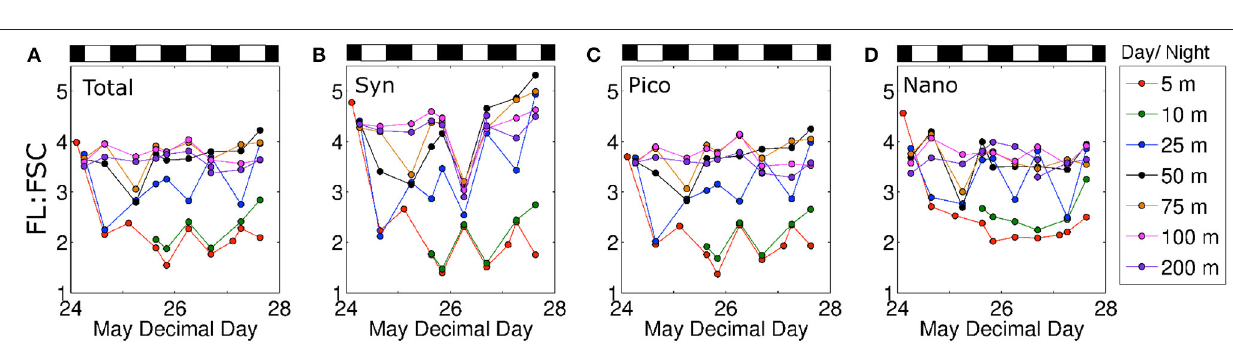
FIGURE 5 | Fluorescence per forward scatter ratios for (A) total community, (B) Synechococcus , (C) picophytoplankton, and (D) nanophytoplankton for 7 depths plotted against time. Black and white bars above plots represent night and day,